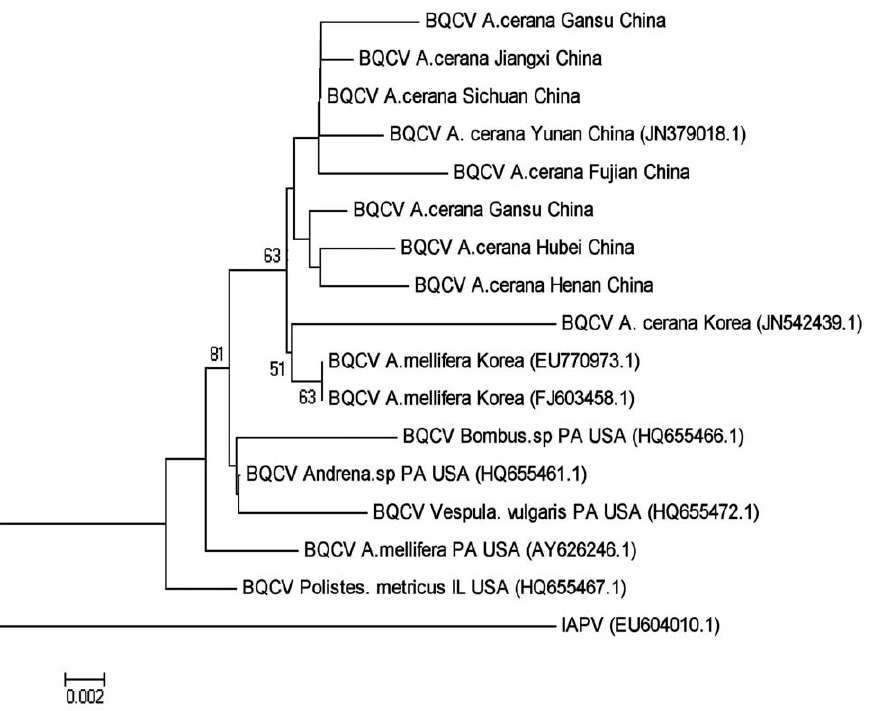
Figure 4. A phylogenetic tree showing the relationship of BQCV isolates. The partial sequences of 3 9 UTR of BQCV from A. cerana collected from different geographic locations of China and from Apis mellifera retrieved from GenBank were aligned using ClustalW. The sequence of IAPV was used as an outgroup to root the tree. Numbers at each node represent bootstrap values as percentages of 500 and only bootstrap values greater than 50% are